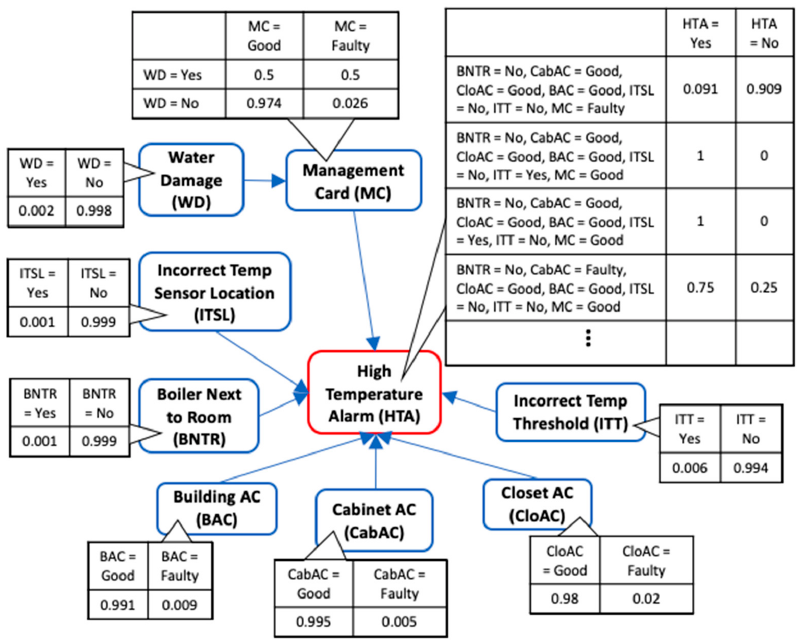
Figure 10. Detailed BN for “Unable to Set Thresholds” fault showing its direct parents only and CPT tables.